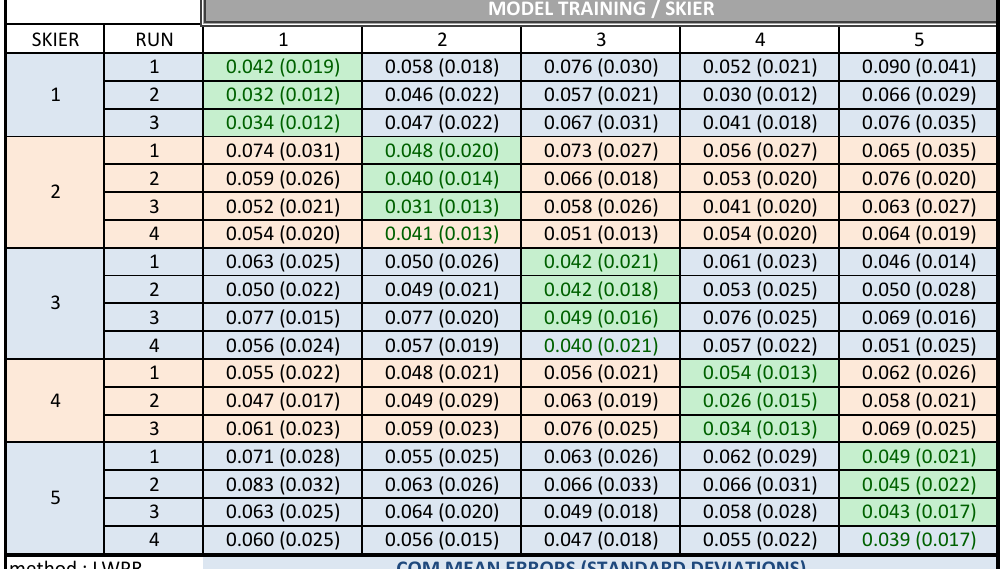
Table 3. Cross-validation of LWPR models. Models were learned using all runs of the same skier (columns). Mean errors and standard deviations of the COM positions of these models were calculated for all 18 runs. All values in the table are given in m.